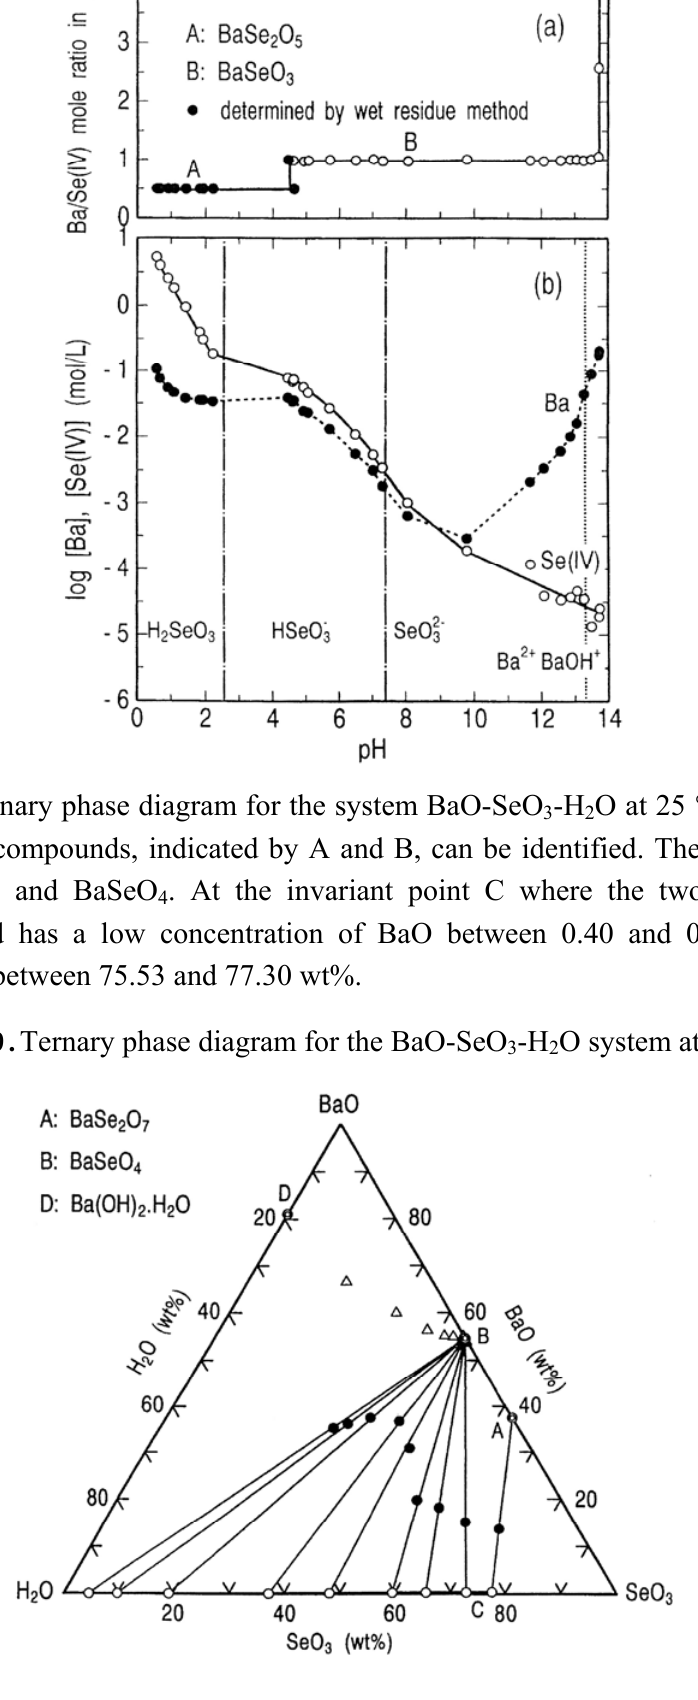
Figure 8. Stability and solubility regions for barium selenites as a function of pH at 25 °C.